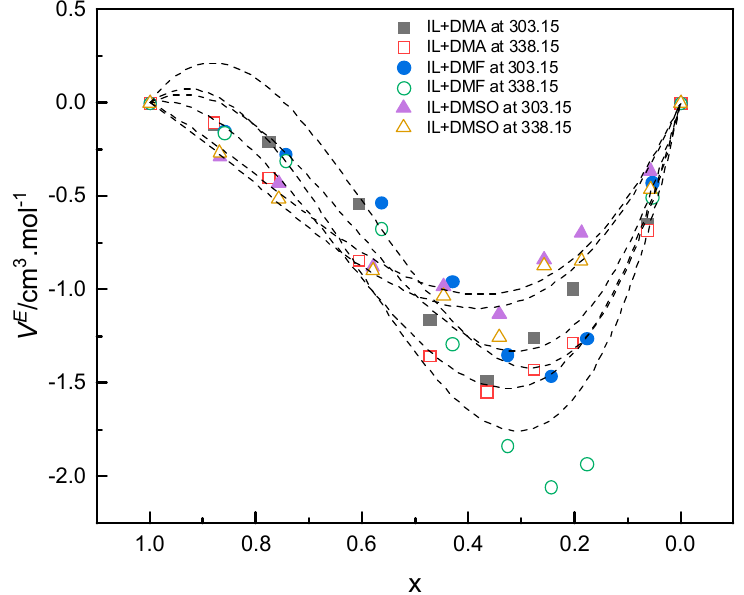
Figure 2. The excess molar volumes for [C 6 mim] [OAc] with solvents as a function of ionic liquid mole fraction. Dash curve calculated by Equation (4).